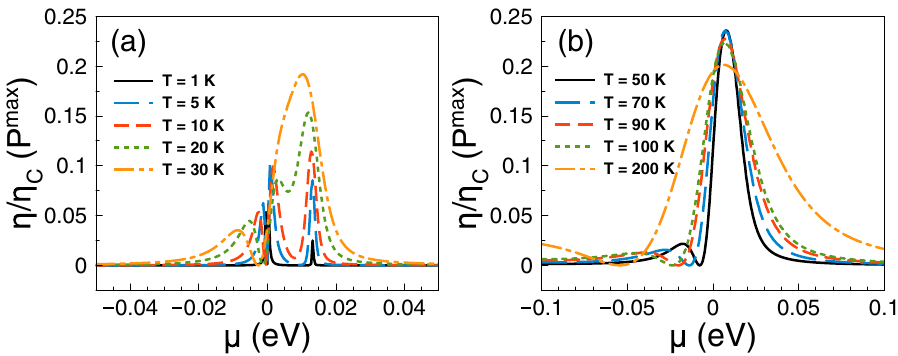
Figure 7. Efficiency at maximum power versus chemical potential for gapless bilayer graphene single barriers at different temperatures: ( a ) from 1 to 30 K and ( b ) from 50 to 200 K. The single barrier structural parameters are the same as in the preceding figures. The maximum efficiency is reached at the temperatures at which ZT is maximum as well.